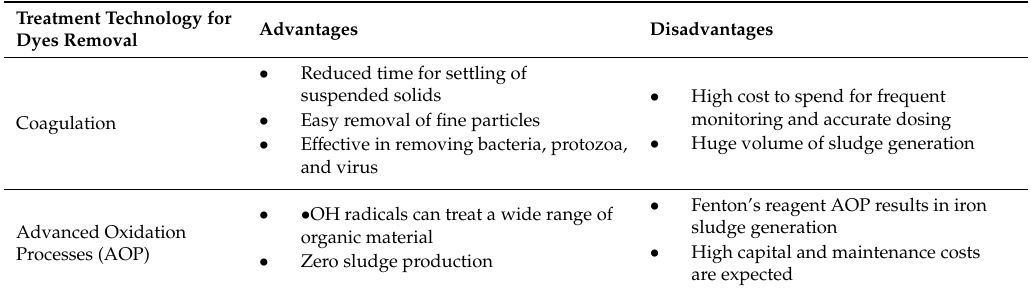
Table 1. The advantages and disadvantages of various treatment technologies for dyes removal from